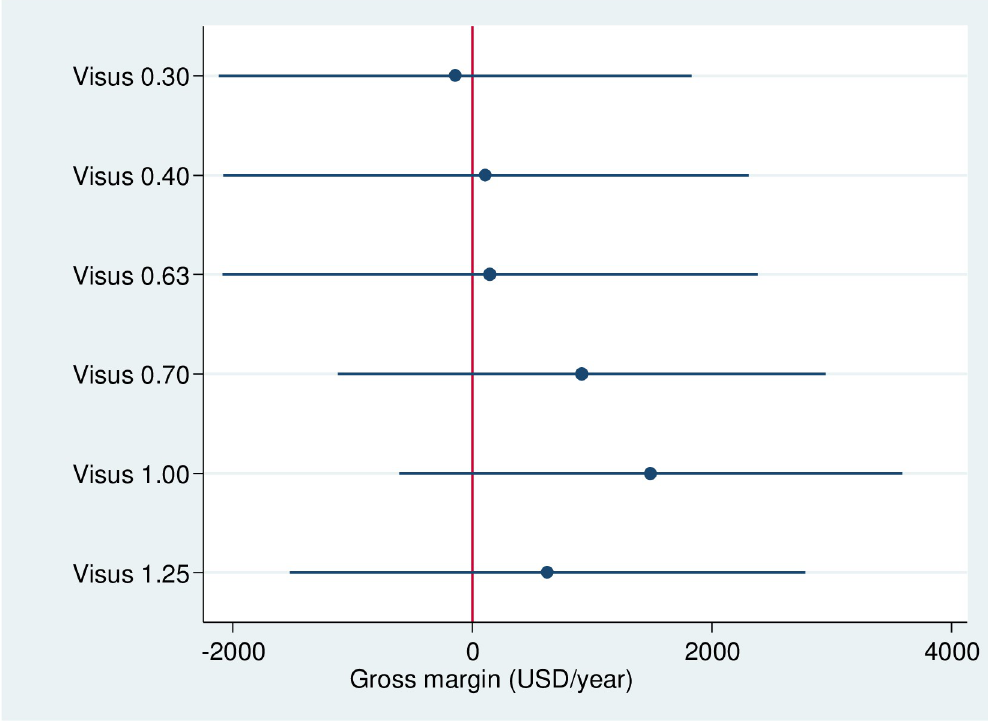
Fig 4. Results from OLS regression on gross margins, with visual acuity groups as independent factorial variable. Total observations = 260. Reference group is visual acuity group with a visus of 0. Control variables are not displayed. Source: Own